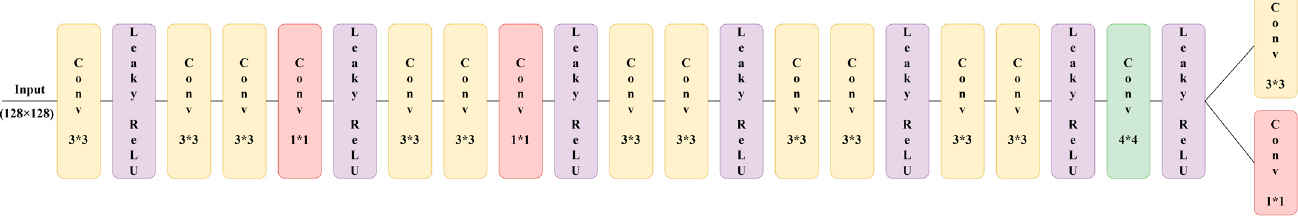
Figure 3. The architecture of the discriminator.